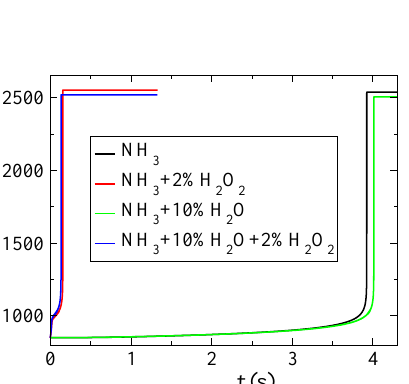
Figure 5. Temperature evolution of pure NH 3 -air, NH 3 -air with 2%H 2 O 2 , NH 3 -air with 10%H 2 O and NH 3 -air with 2%H 2 O 2 + 10%H 2 O mixtures.